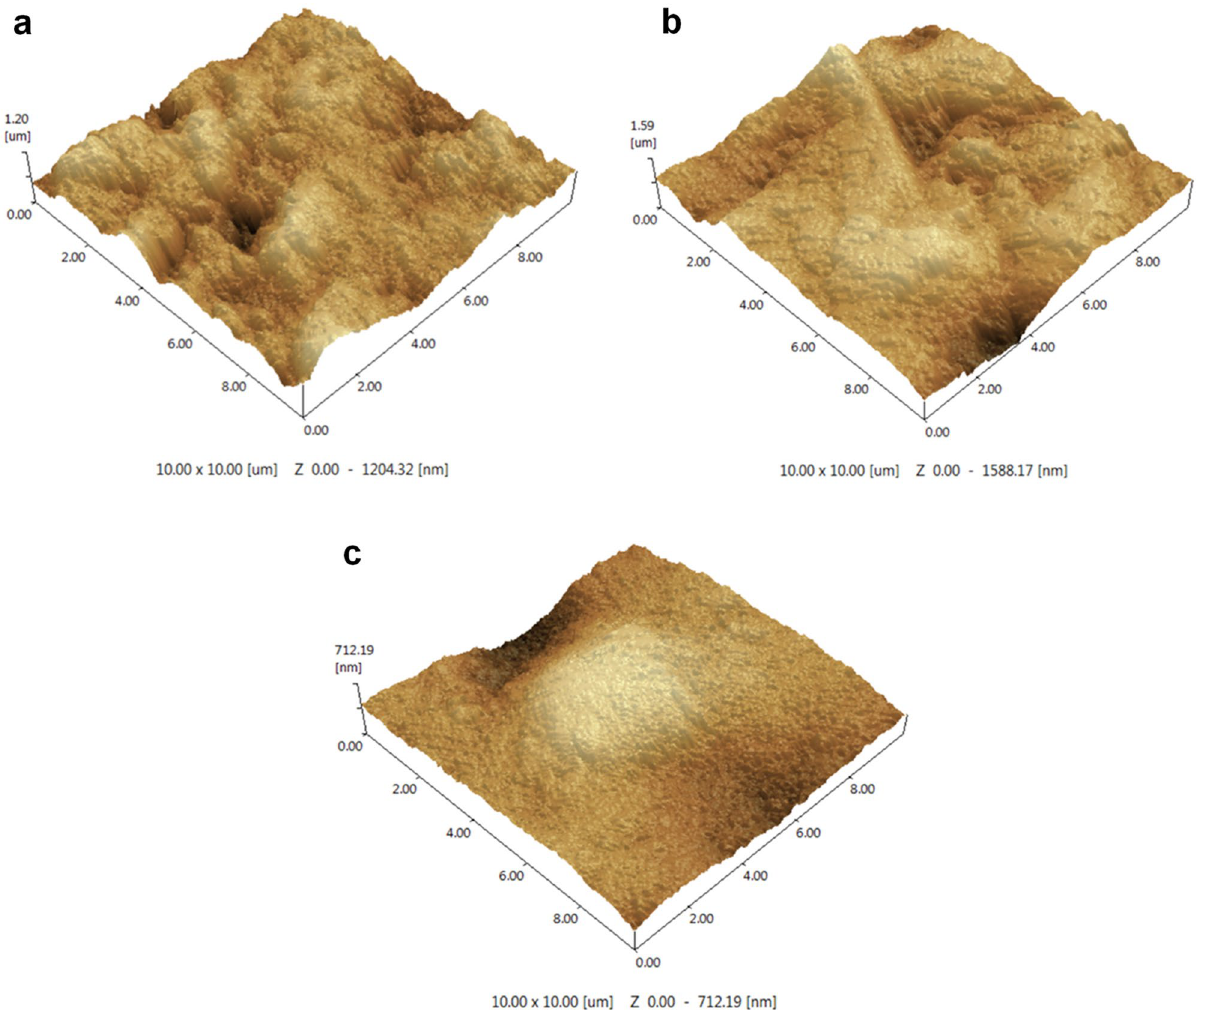
Figure 2. Representative AFM images (10 μm × 10 μm). The surface morphologies after 14 days pH cycling were shown in the presence of ( a ) double distilled water (DDW) alone, ( b ) GERM CLEAN, ( c ) 1000 ppm fluoride (NaF).